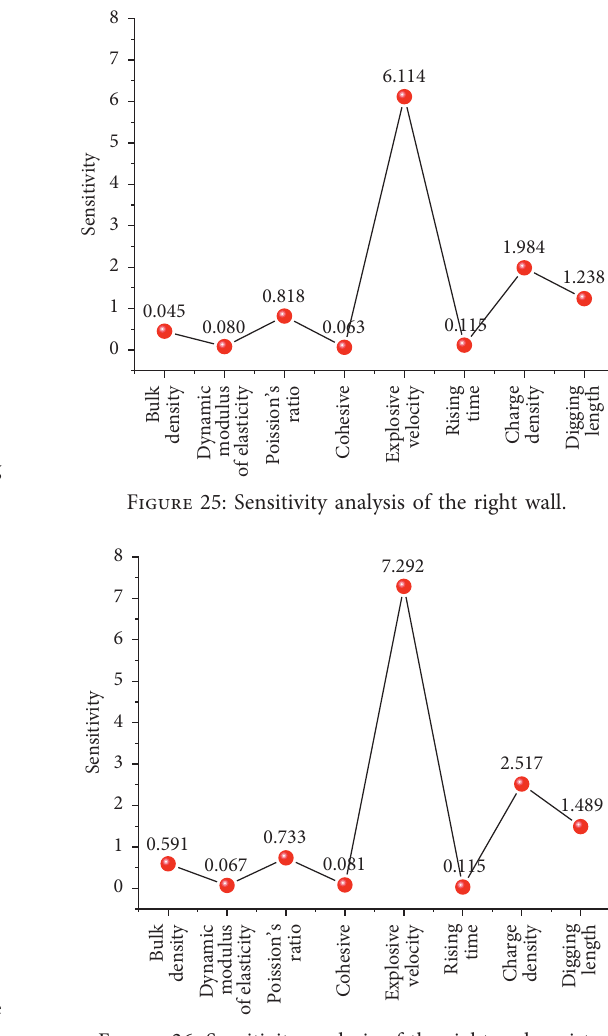
Figure 26: Sensitivity analysis of the right arch